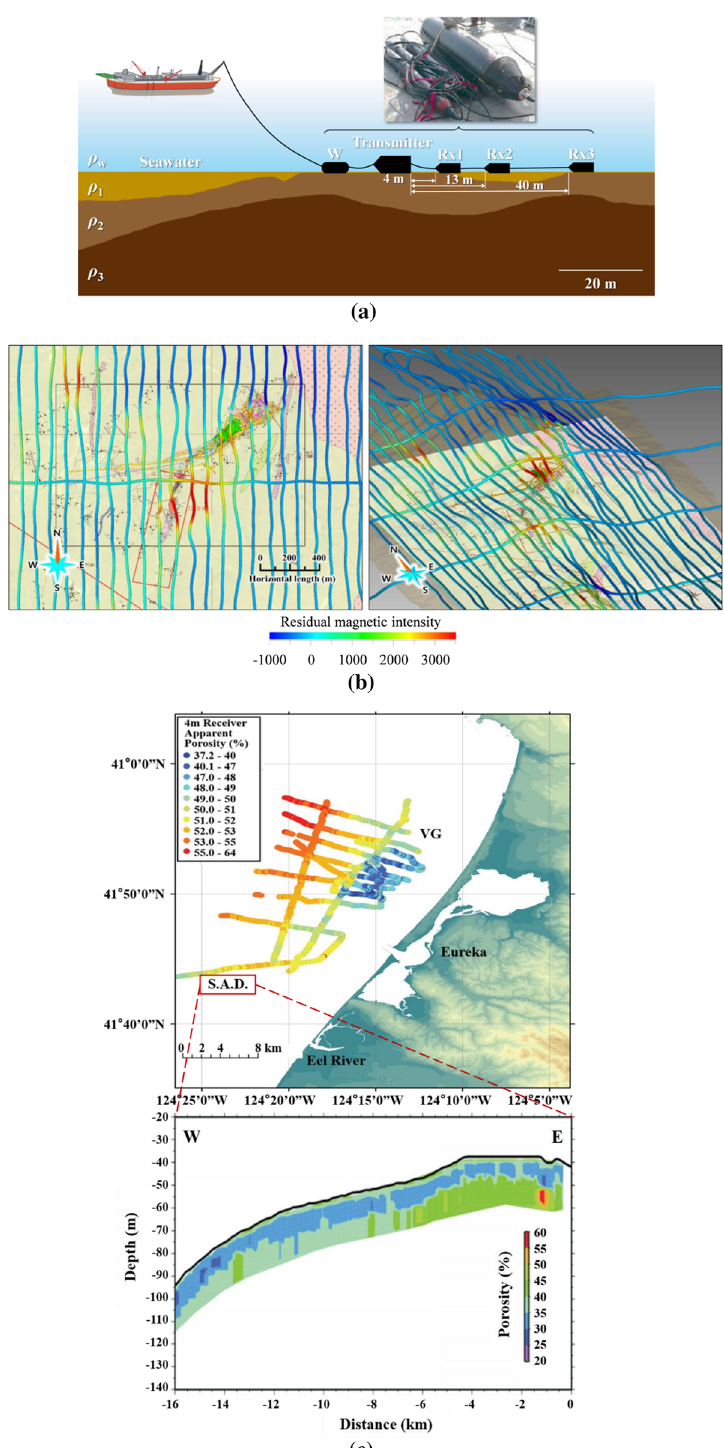
Fig. 9 Magnetic exploration a Working principle (modified from Hsu et al. 2014), where W is the weight as a depressor unit (The towed electromag- netic transmitter composed of 3 receivers (Rx1, Rx2, and Rx3, tuned to measure these mag- netic fields different frequen- cies) and a transmitter (a hori- zontal magnetic dipole) forming an array with a total length of 40 m on the seafloor generates harmonic magnetic fields over a range of frequencies (Hsu et al. 2014)) b Example output on land (modified from Kim 2021) and c Example output on the exploration of underwater natural gas resources (modified from Evans